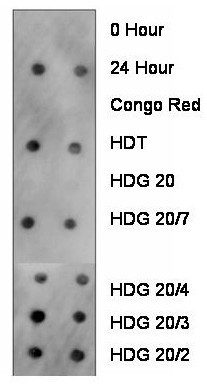
Various 20-mers with thymine modifications were tested for inhibitory activity in the assay outlined in Figure 1. HDT, 20-mer with all T's; HDG, 20-mer with all G's; HDG 20/7, 20-mer with every 7th nucleotide replaced with T; HDG 20/4, 20-mer with every 4th nucleotidereplaced with T HDG 20/3, 20-mer with every 3rd nucleotide replaced with T; HDG 20/2, 20-mer with every other nucleotide replaced with T. 0 hour, reaction stopped at zero time point; 24 hour, reaction lacking oligonucleotide and reaction stopped at 24 hours; Congo Red, incubation with Congo Red (10 μM) for 24 hours.